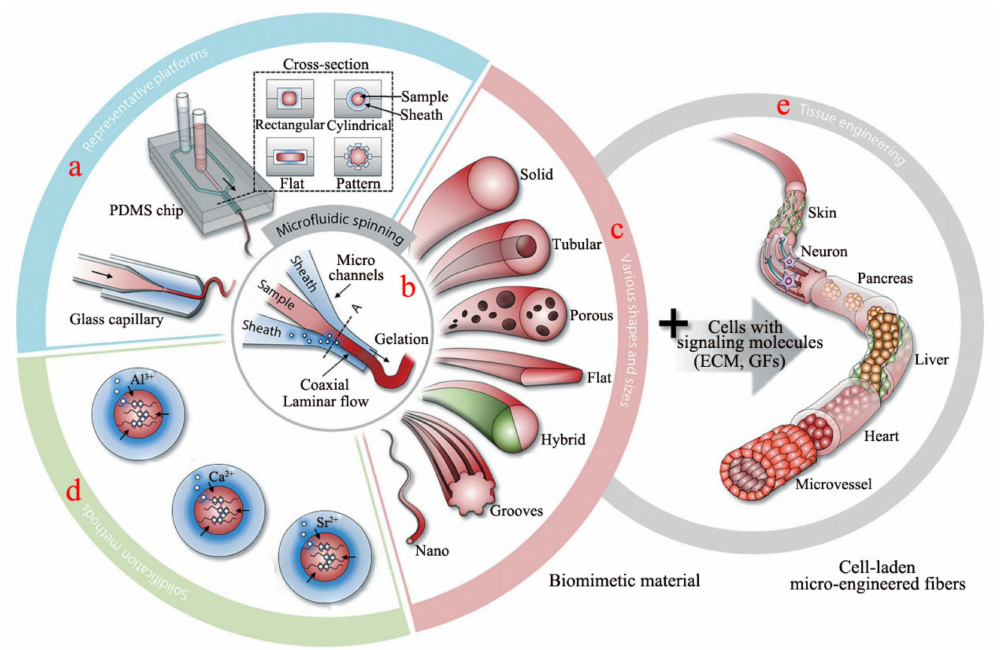
Figure 7. ( a ) The micro-channel device with various cross sections, ( b ) Overview of the microfluidic platforms composed of coaxial core and sheath fluids, ( c ) Anisotropic structure of alginate fiber fabricated by the MST, ( d ) Various metal cations cross-linked with alginate polymer to fabricate fiber and ( e ) The cell load micro-engineered fibers as the desired biomimetic